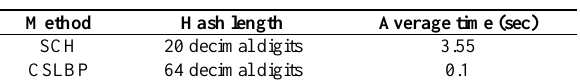
Table 2. Time and hash length comparisons among different